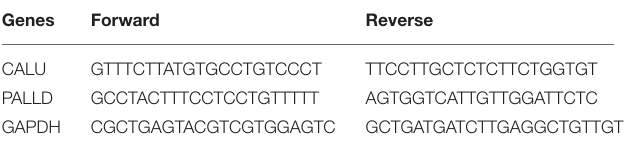
TABLE 1 | Primers